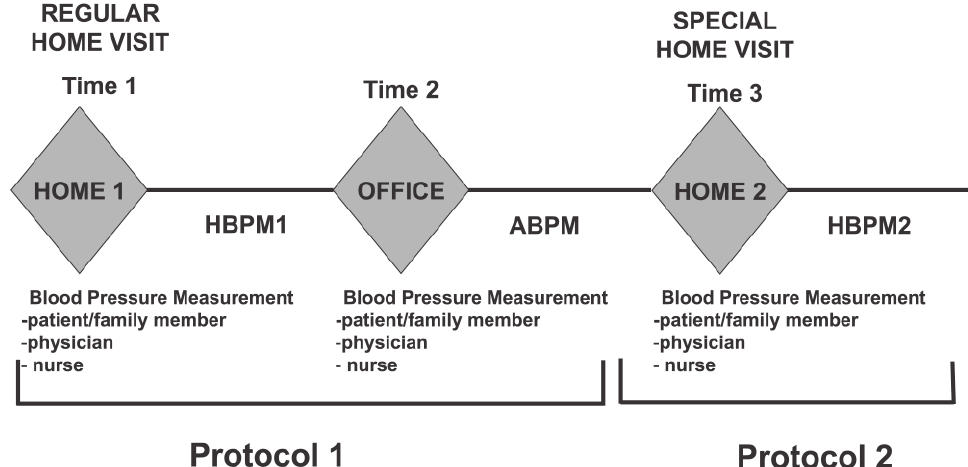
Figure 1 - Blood Pressure